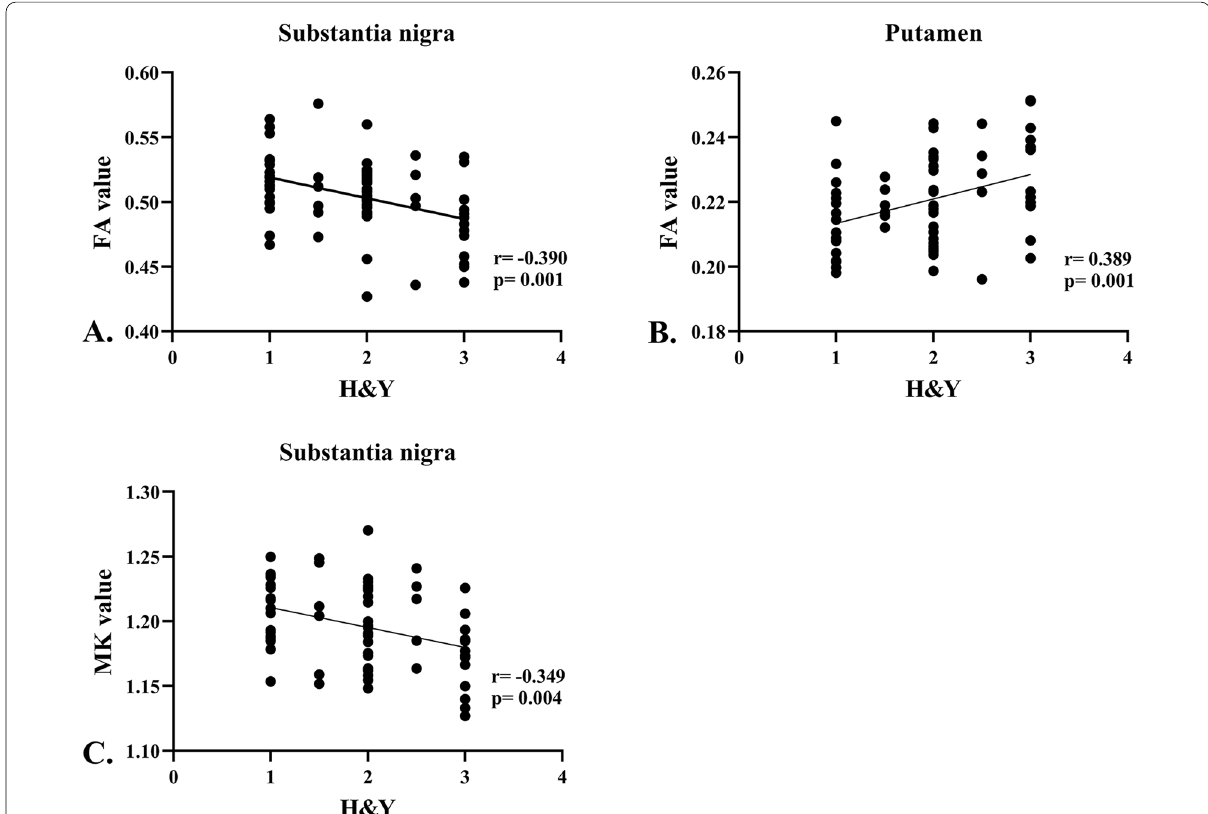
Fig. 6 Spearman’s correlation between the diffusion kurtosis imaging scalar measures and Hoehn and Yahr scales. A . Negative correlation between the fractional anisotropy (FA) values in the substantia nigra and Hoehn and Yahr (H&Y) scales. B . Positive correlation between the FA values in the putamen and H&Y scales. C . Negative correlation between the mean kurtosis values in the substantia nigra and H&Y